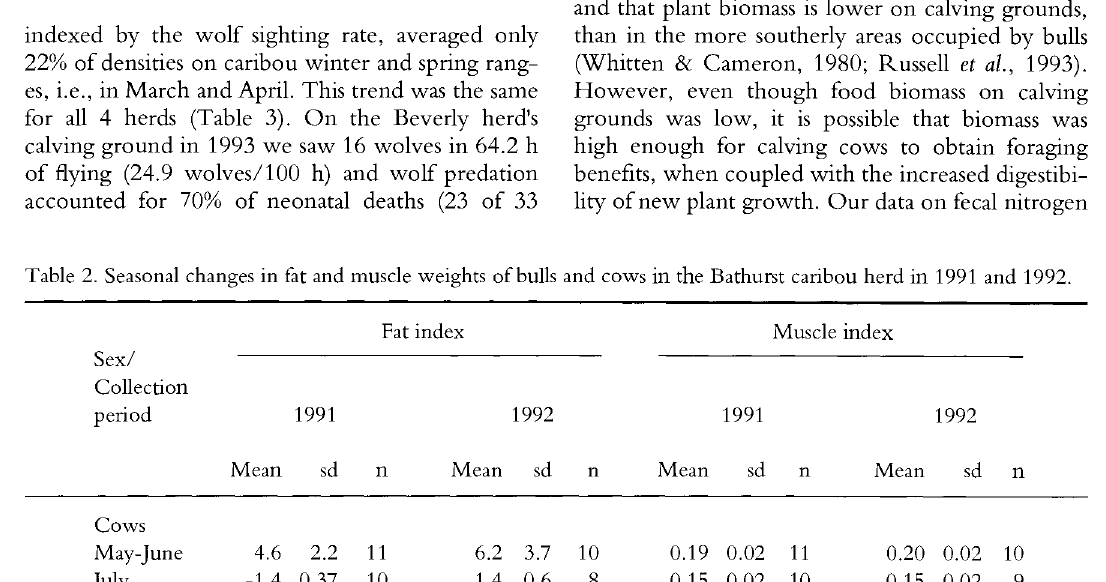
Fig. 3. Fecal nitrogen concentrations from areas occupied by bulls and cows in the Bathurst caribou herd in 1990.